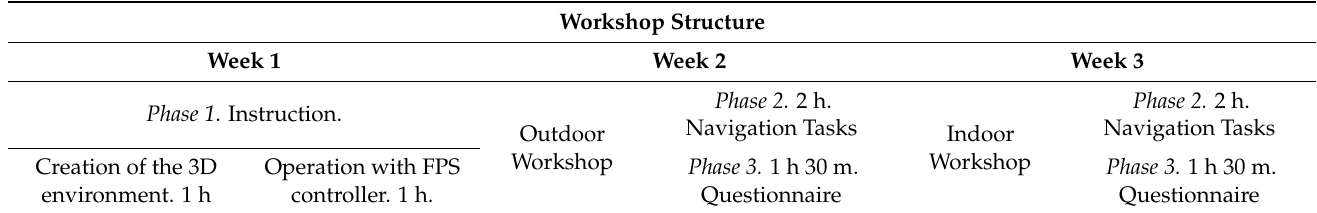
Table 2. Workshop structure. Workshop